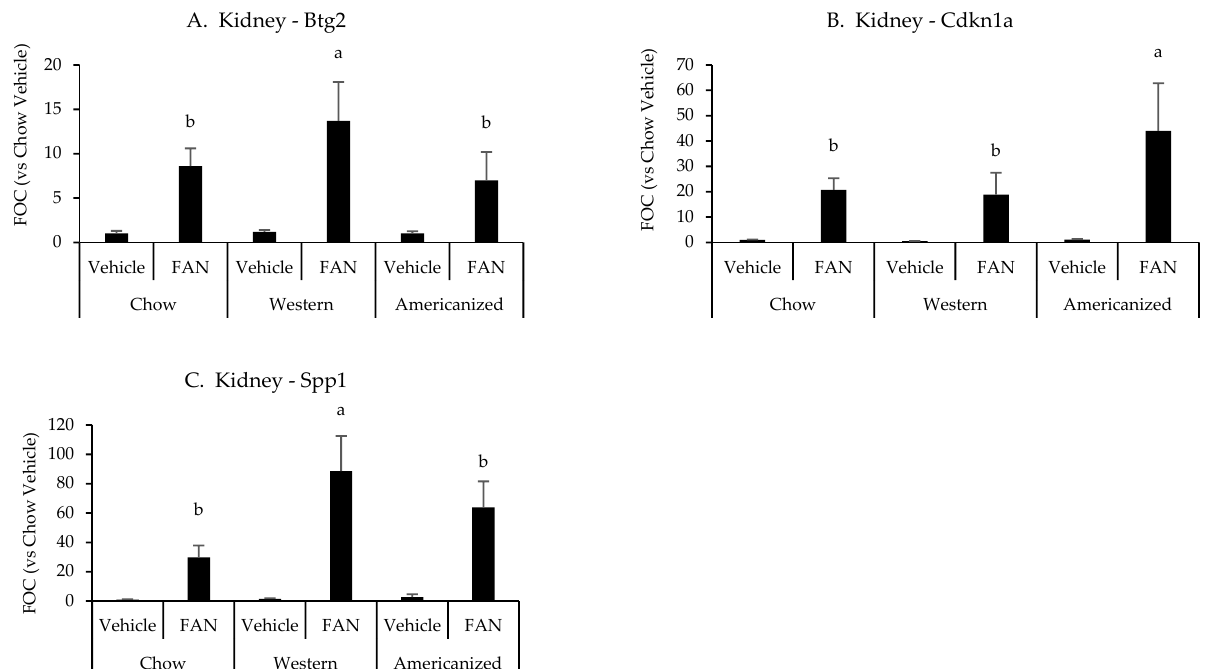
Figure 2. Kidney gene expression data from the diet-FAN study. Data are presented normalized to chow-fed mice with vehicle treatment (average + STD). ( A ) Kidney— Btg2 , ( B ) Kidney— Cdknla , ( C ) Kidney— Spp1. Different superscript letters (a vs. b) signify significant difference between diets ( p < 0.05) as determined by Two-Way ANOVA with Tukey Post Hoc test. Treatments with similar superscript letters are not statistically different ( p > 0.05). RT-PCR data and statistics are presented in Appendix F Table A4. n = 4 for each diet-treatment combination. FOC—fold change.